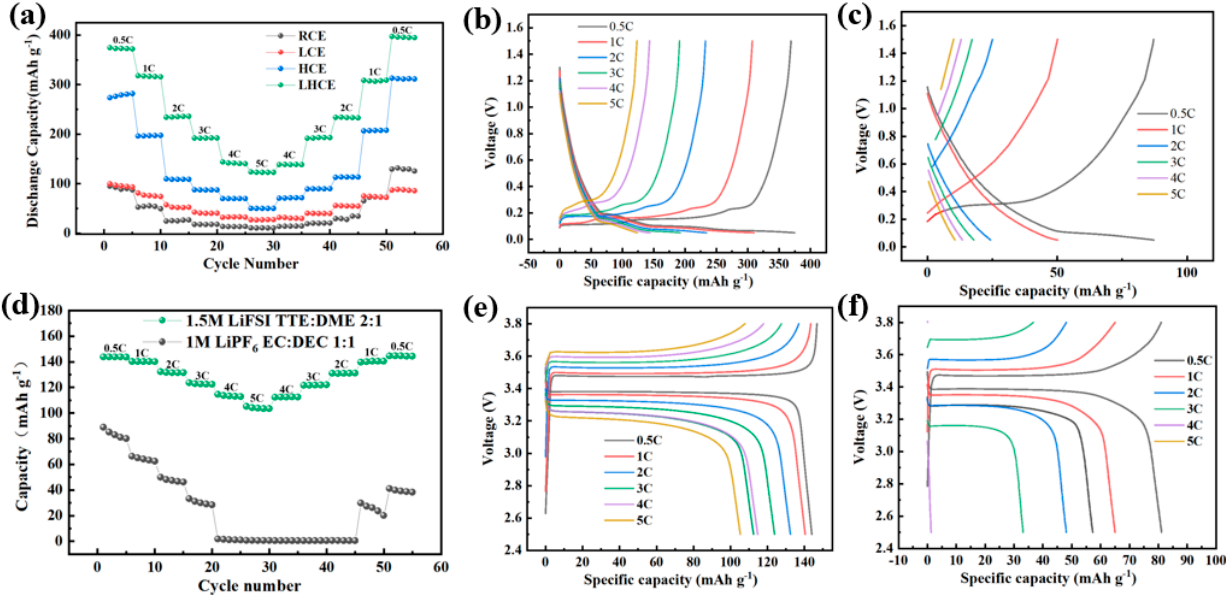
Figure 6. Rate performance of Li||C batteries ( a ) in four electrolytes, ( b ) capacity-voltage curves at different rates in LHCE, and ( c ) capacity-voltage curves at different rates in RCE. Rate performance of LFP||Li batteries ( d ) in two electrolytes, ( e ) capacity-voltage curves at different rates in LHCE, ( f ) capacity-voltage curves at different rates in commercial electrolytes.